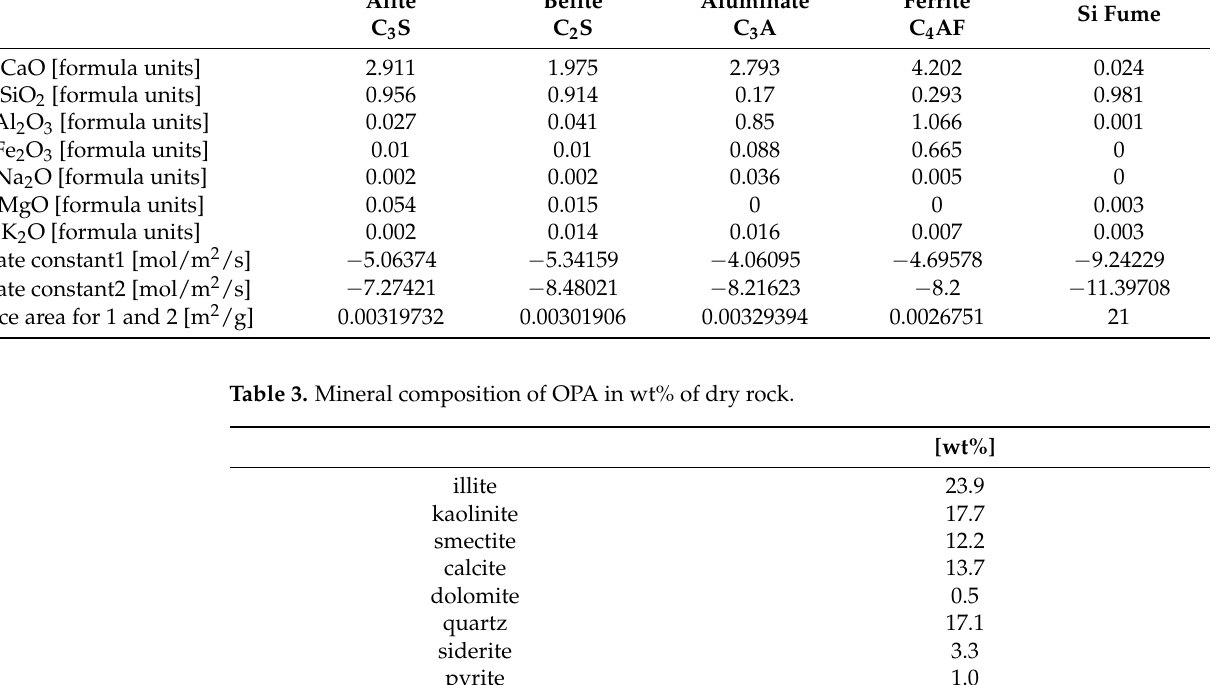
Table 2. Stoichiometric clinker composition calculated from measured cement bulk chemical composition after Taylor [37], measured silica fume composition, implemented dissolution rates, and surface areas. Alite Belite C 3 S